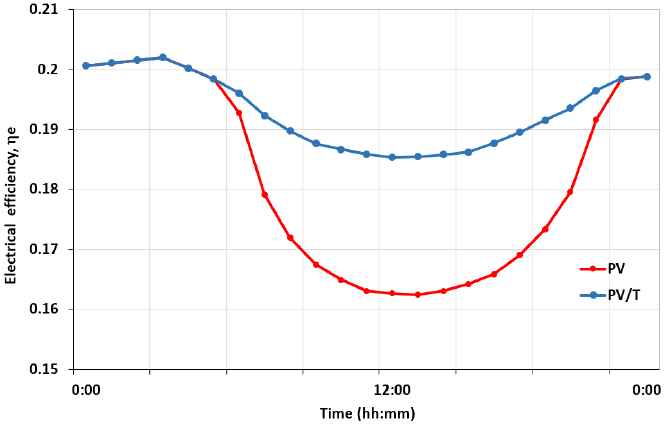
Figure 10. Comparison of PV and PV/T electrical efficiency.